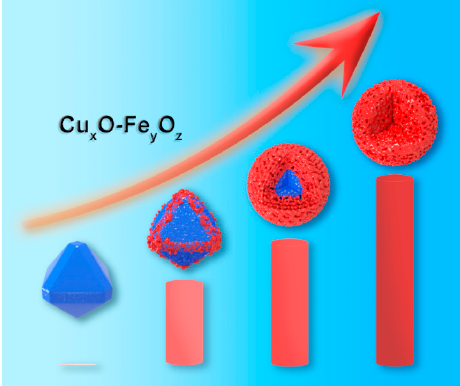
Figure 6. Formation of the Cu x O-Fe y O z structure.